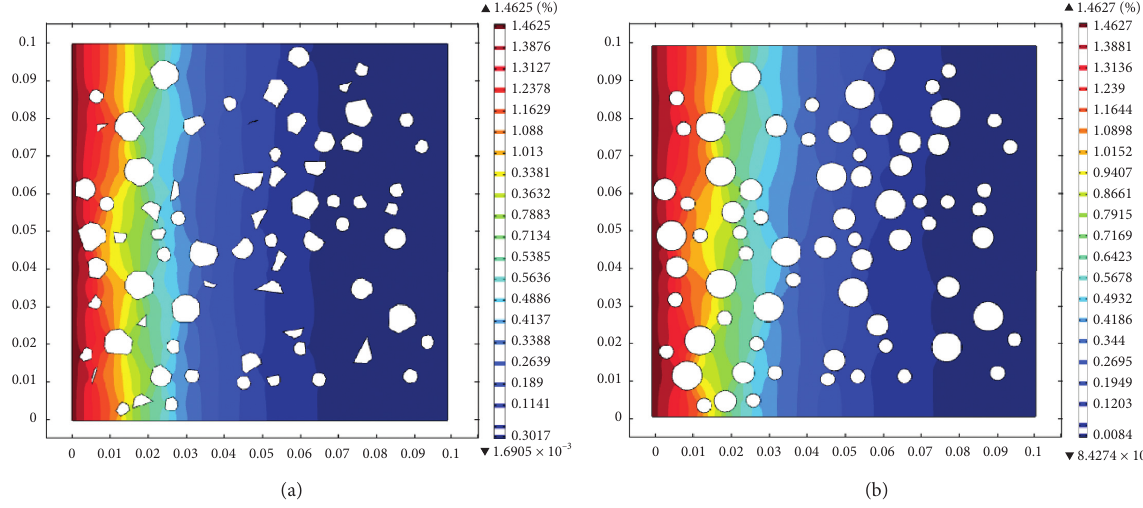
Figure 8: Distribution of chloride concentration in concrete. (a) Polygonal aggregate. (b) Circular aggregate.